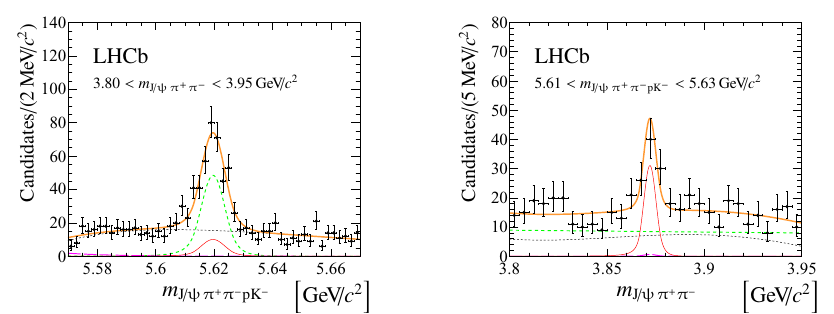
Figure 3. Projection of the two-dimensional distribution of (left) J / ψπ + π − pK − and χ c1 (3872)pK − candidates. A signal component, describing (right) J / ψπ + π − masses for the Λ 0 b → χ c1 (3872)pK − decays (red), a component describing nonresonant Λ 0 the true Λ 0 b → decays with no intermediate χ c1 (3872) state (NR) (green), a component describing random